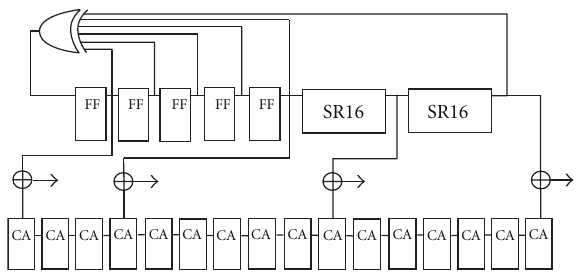
Figure 6: Schematic of a hybrid CA/LFSR FPGA implementation. SR16 represent the LUT-based 16-bit shift registers. Combined with the flip-flops (FFs), it forms a 37-bit